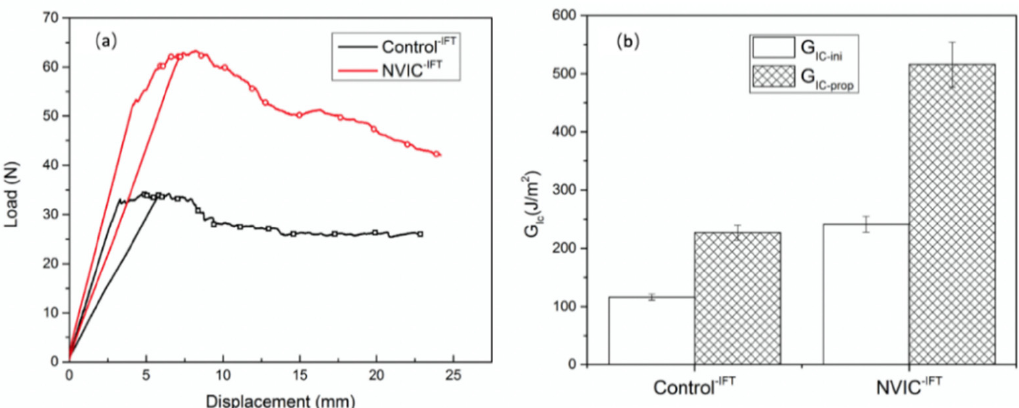
Figure 7. Results of the Mode I toughness test. ( a ) Typical DCB load-displacement curve, ( b ) Mode I interlaminar toughness.